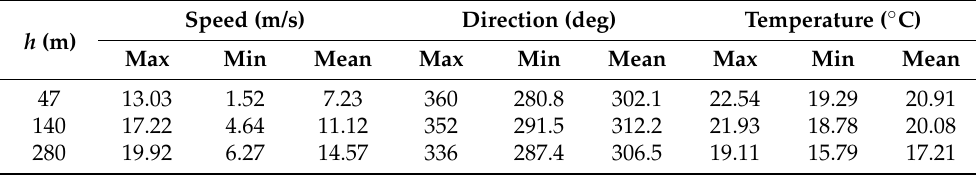
Table 3. Comparison of the wind data of three heights related to the duration between the two vertical lines in Figure